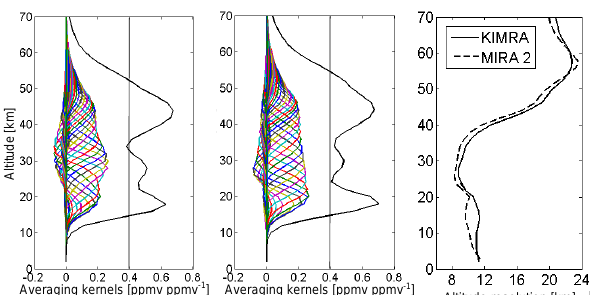
Figure 2. Left and middle: mean averaging kernels for KIMRA and MIRA 2 O 3 retrieved profiles used for the comparison. The mea- surement response divided by 2 is also shown as the solid black line. The vertical black line indicates a measurement response of 0.8. Right: the altitude resolution of the profiles, given by the full width at half maximum (FWHM) of the averaging